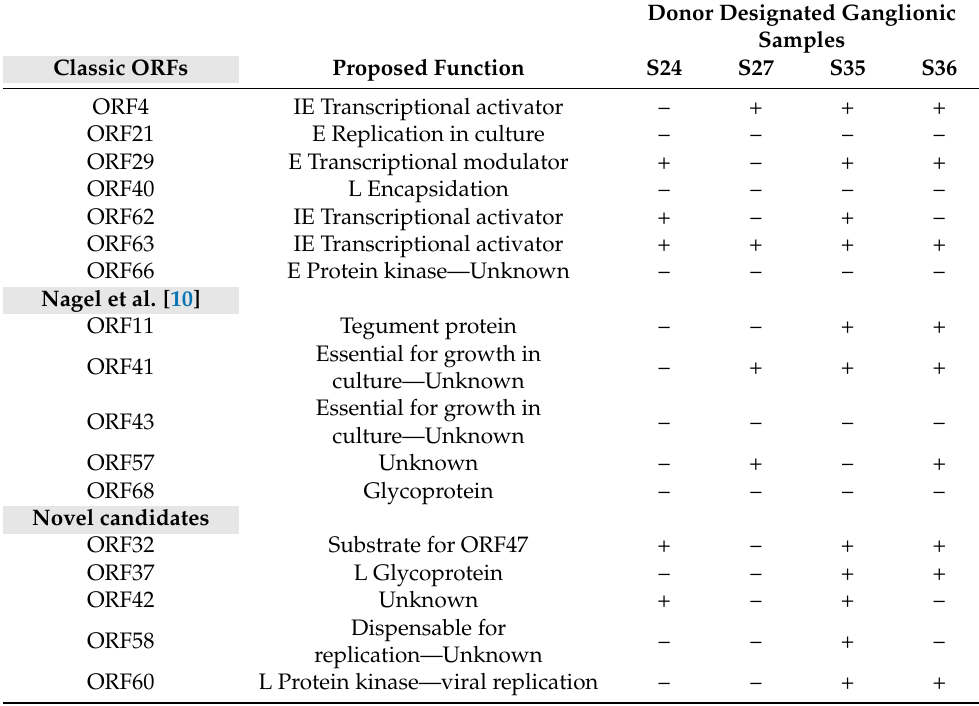
Table 1. Activity profile of VZV transcripts detected in the current